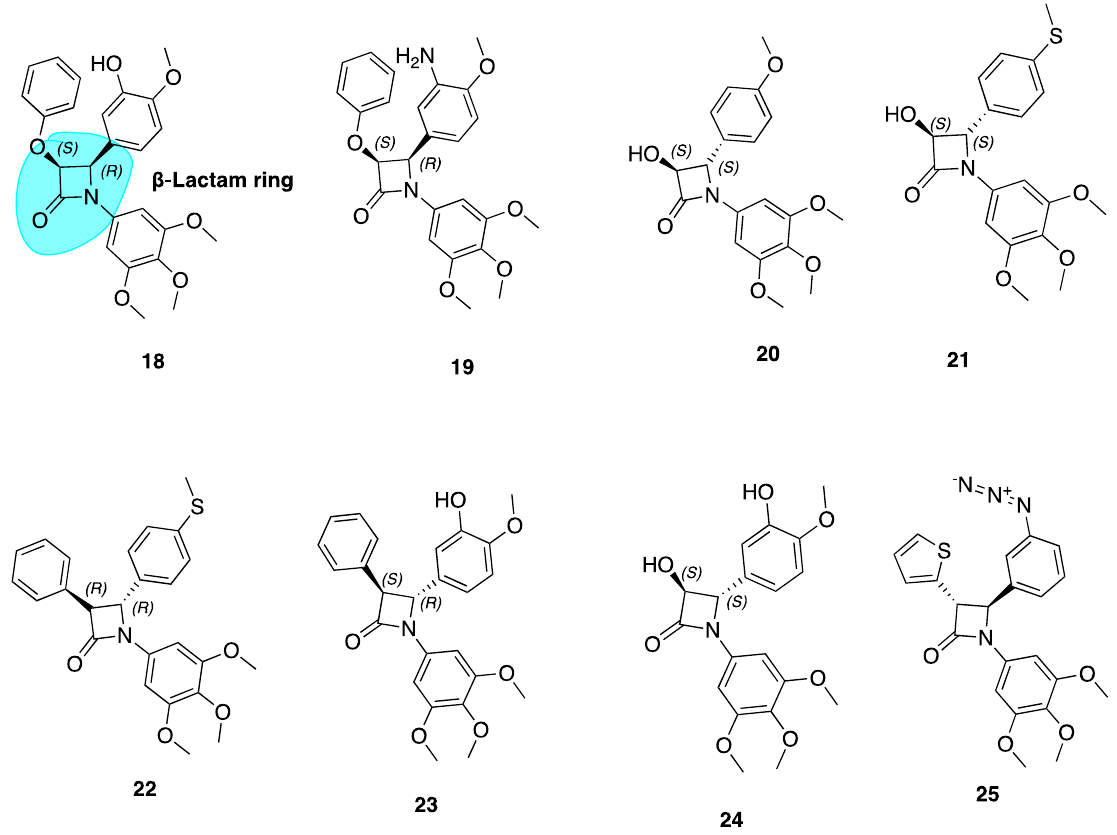
Figure 5. Structures of β -Lactams 18 - 25 . ( Cis isomers of 18 and 19 and trans isomers of 20 – 24 isolated only. (One enantiomer represented for each compound).